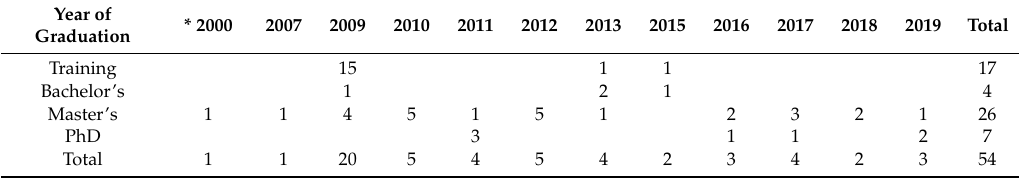
Table 3. Number of students from Kazakhstan to Japan who used Bolashak program by degree level between 2000 and 2019.